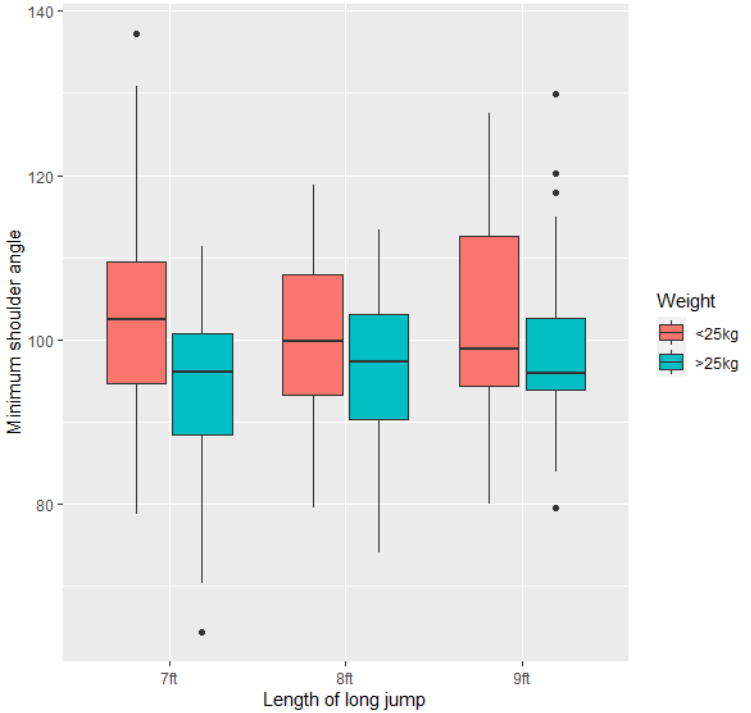
Figure 8. Minimum apparent shoulder angle (degrees) across all the study dogs ( n = 21) at the three long jump lengths (7 ft, 8 ft, 9 ft).